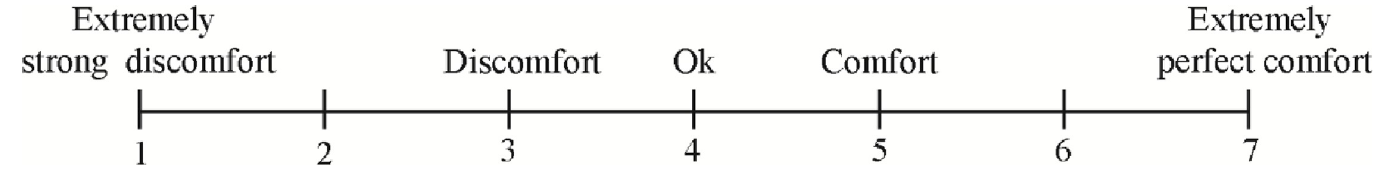
Fig 8. 7-point likert scales.